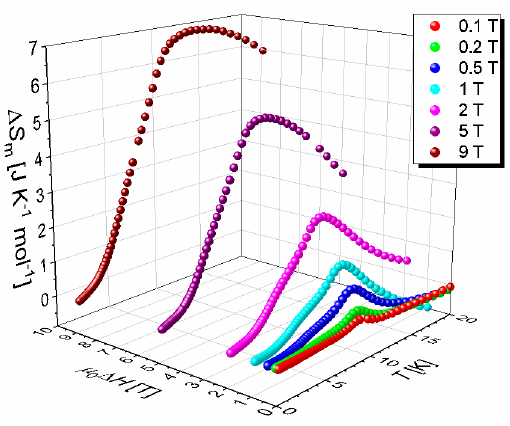
Figure 16. Temperature dependence of the isothermal entropy change Δ S m . Table 3. Peak values of Δ S m and Δ T ad of 3 .